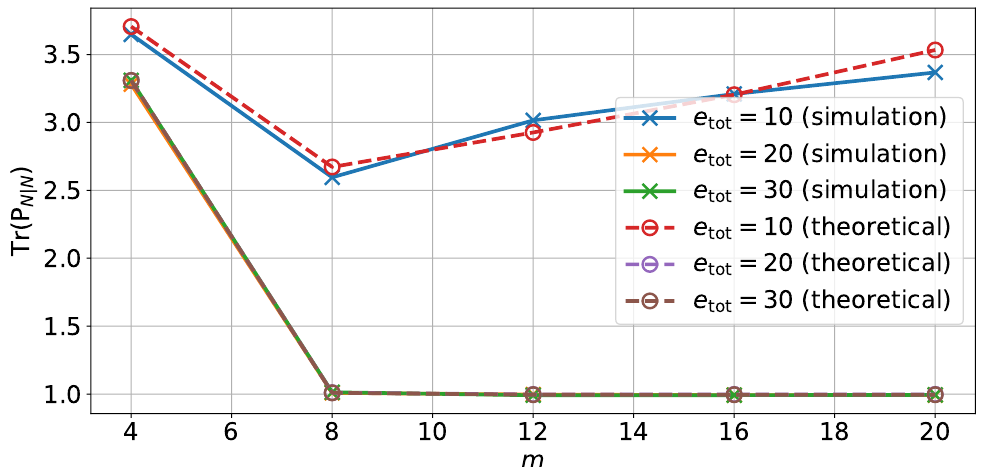
Figure 5. Theoretical and simulated variance of estimation error on the position depending on the number of quantization bits using an unreliable memory for different total energy values e tot in the case of the large-size example.